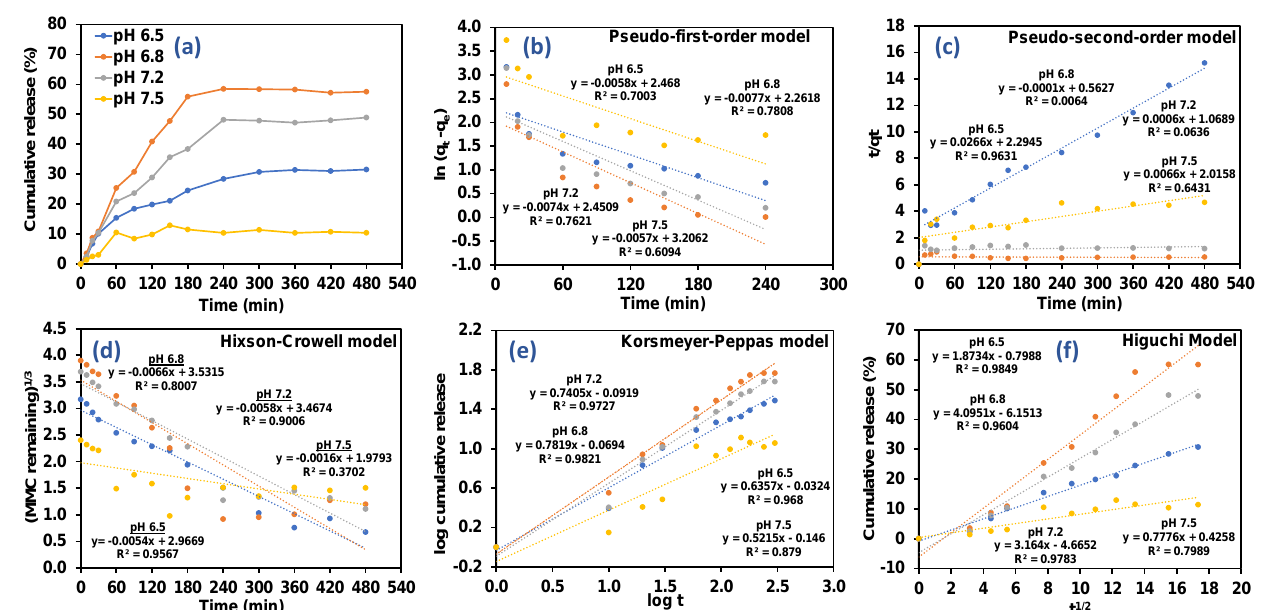
Figure 7. Drug release in ( a ) different release medium with pH 6.5, 6.8, 7.2 and pH 7.5; and drug release data fitted with five different pharmacokinetics models ( b ) Pseudo-first-order model, ( c ) Pseudo-second-order model, ( d ) Hixson-Crowell model, ( e ) Korsmeyer-Peppas model, and ( f ) Higuchi model.